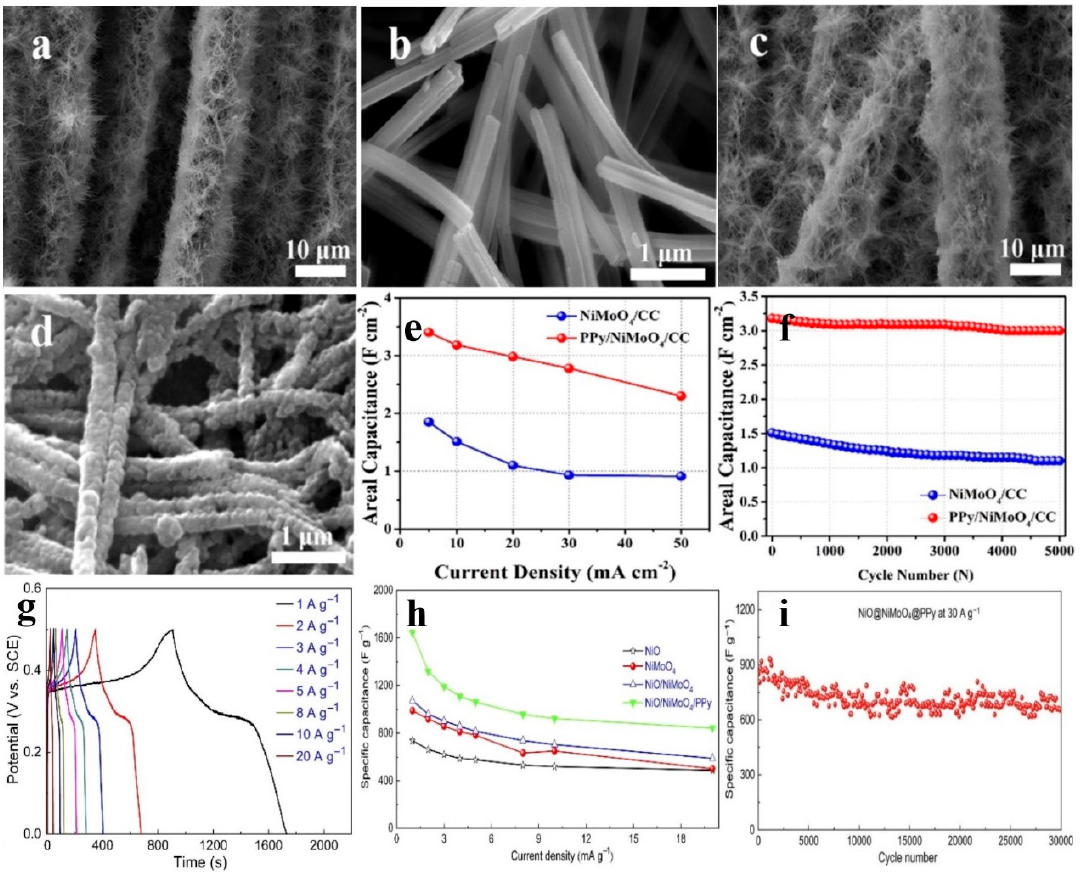
Figure 9. SEM images of the NiMoO 4 /CC and PPy/NiMoO 4 /CC electrodes: ( a , c ) low − magnification, ( b , d ) high − magnification, ( e ) specific capacitance at various current densities, and ( f ) cycling performance at a discharge rate of 10 mAcm − 2 [146]. Reproduced from Ref. [146] with permission from Elsevier, 2020. ( g ) GCD curves of NiO − NiMoO 4 − PPy at different current densities (1–20 Ag − 1 ), ( h ) Specific capacitances of NiO, NiMoO 4 , NiO − NiMoO 4 and NiO − NiMoO 4 − PPy calculated by GCD curves, ( i ) Long − term cycling stability of NiO − NiMoO 4 − PPy at 30 Ag − 1 [148]. Reproduced from Ref. [148] with permission from Elsevier, 2020.